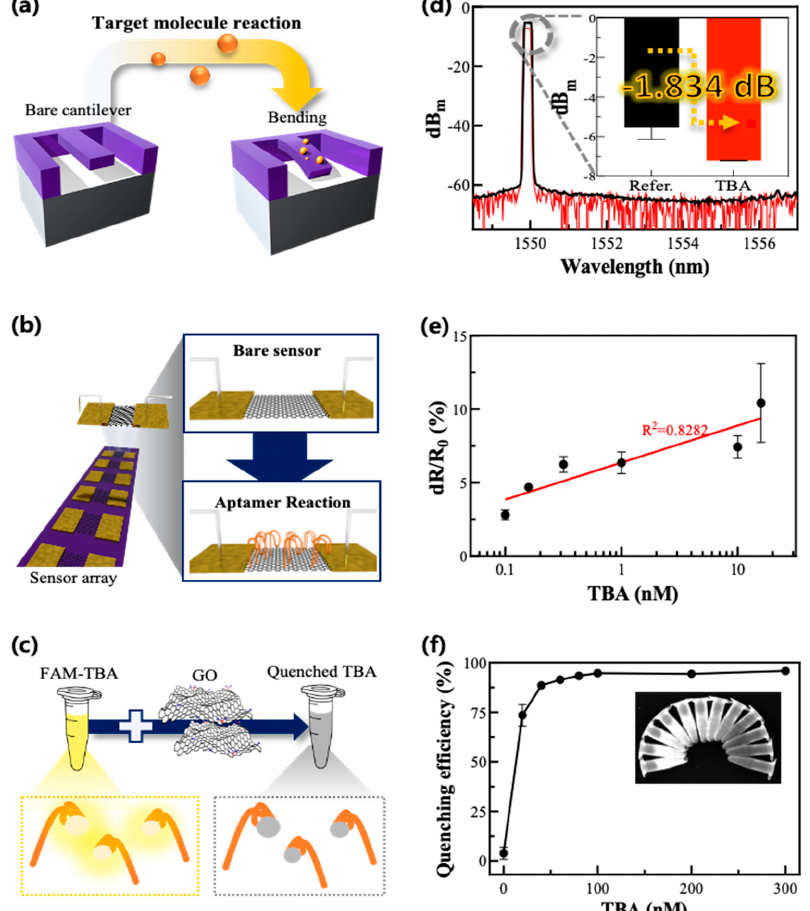
Figure 2. Experimental principles and schematic diagrams are based on each measurement method and experimental results after TBA absorption on the sensing substrate. ( a , d ) shows an illustration and a representative graph showing the mechanical method. ( b , e ) shows an illustration and representative graph showing the electrical method. ( c , f ) shows that the standard deviation (SD) value after TBA reaction in ( d ) is about 0.018. All experiments except for the highest concentration of TBA in ( e ) have SD values under 0.74. The highest concentration condition, 20 nM TBA, has an SD value of 2.681. In ( f ), the SD values of two points under the 20 nM TBA concentration were 3.081 and 5.493, in ascending using the TBA-FAM/GO-based strategy. Briefly, various concentrations (0–10 μ M) of